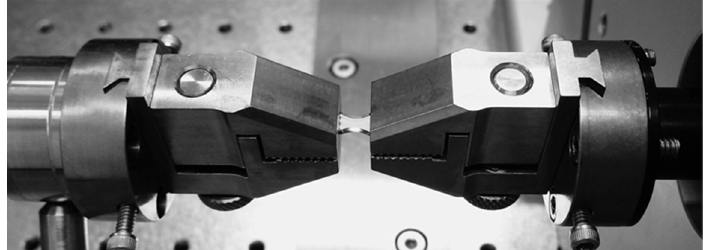
Figure 9. Uniaxial test set up: the dog-bone-shaped sample was held by the two grips, and elongated by the electromagnetic actuators.